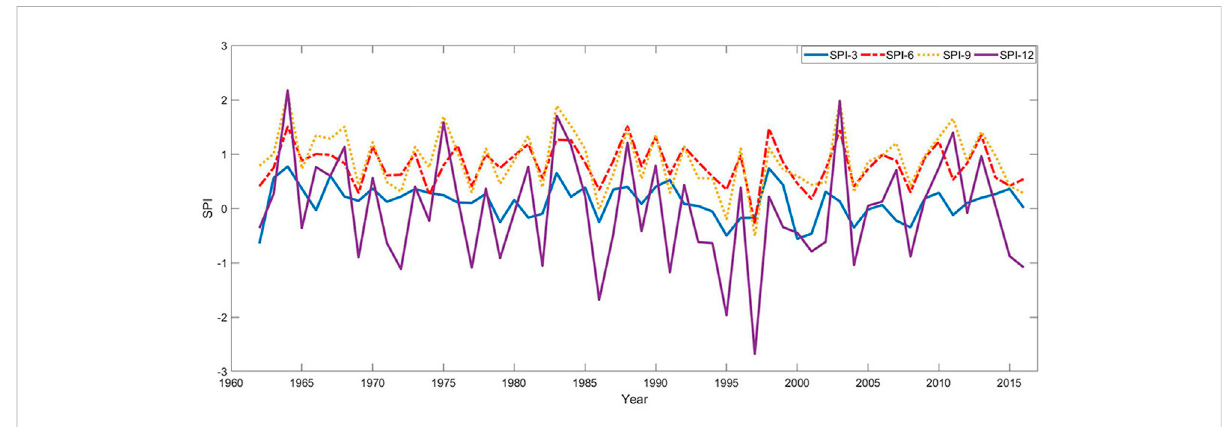
FIGURE 2 Meteorological drought on four time